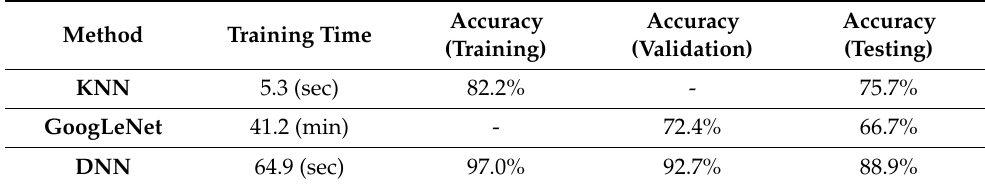
Table 9. Comparison of accuracy between KNN, GoogLeNet, and the proposed approach with rotation 40% and FM-10%.